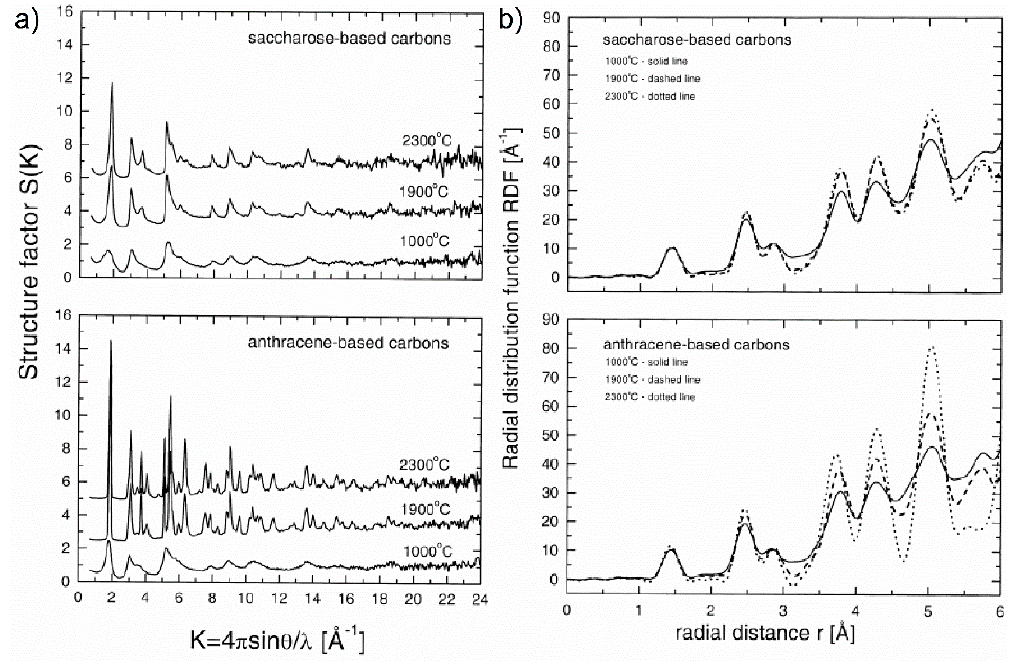
Figure 14. ( a ) Comparison of structure factors and ( b ) radial distribution functions for saccharose- and anthracene-based carbons heat-treated at 1000, 1900, and 2300 °C. Reproduced with permission from Szczygielska et al. [71]. Copyright Elsevier, 2001.